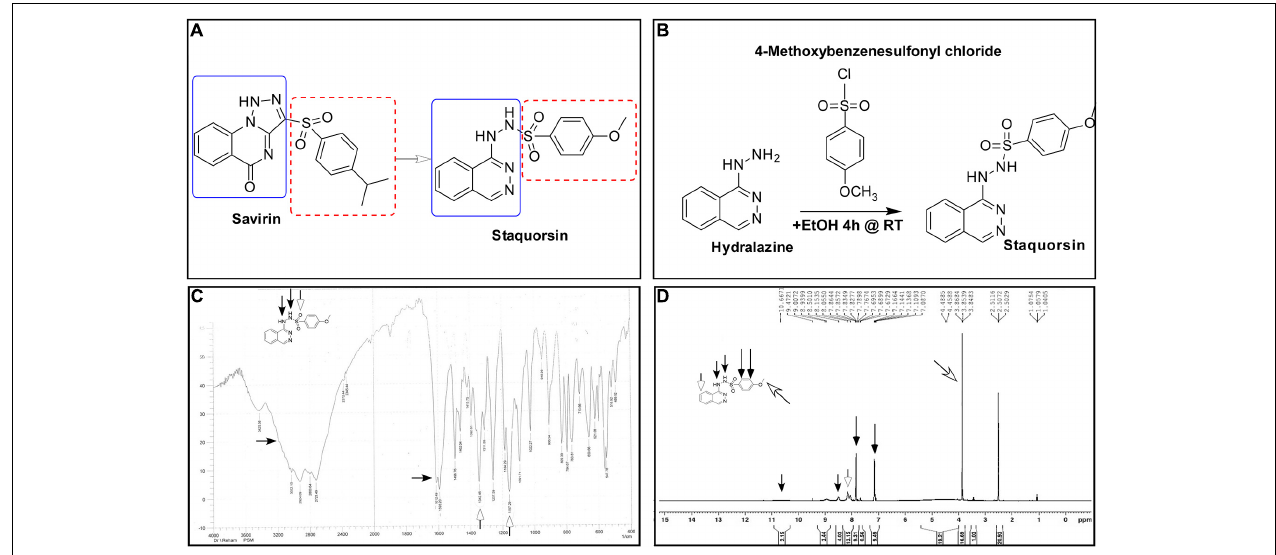
FIGURE 1 | Synthesis and validation of staquorsin. (A) Rationale for the design of the staquorsin molecule as being an analogue for savirin. (B) The synthesis scheme used for obtaining staquorsin. (C) An IR spectrum chart for staquorsin. (D) A 1 H NMR spectrum chart for staquorsin. In both charts, the peaks corresponding to the respective moieties are marked with same arrows labeling the chemical